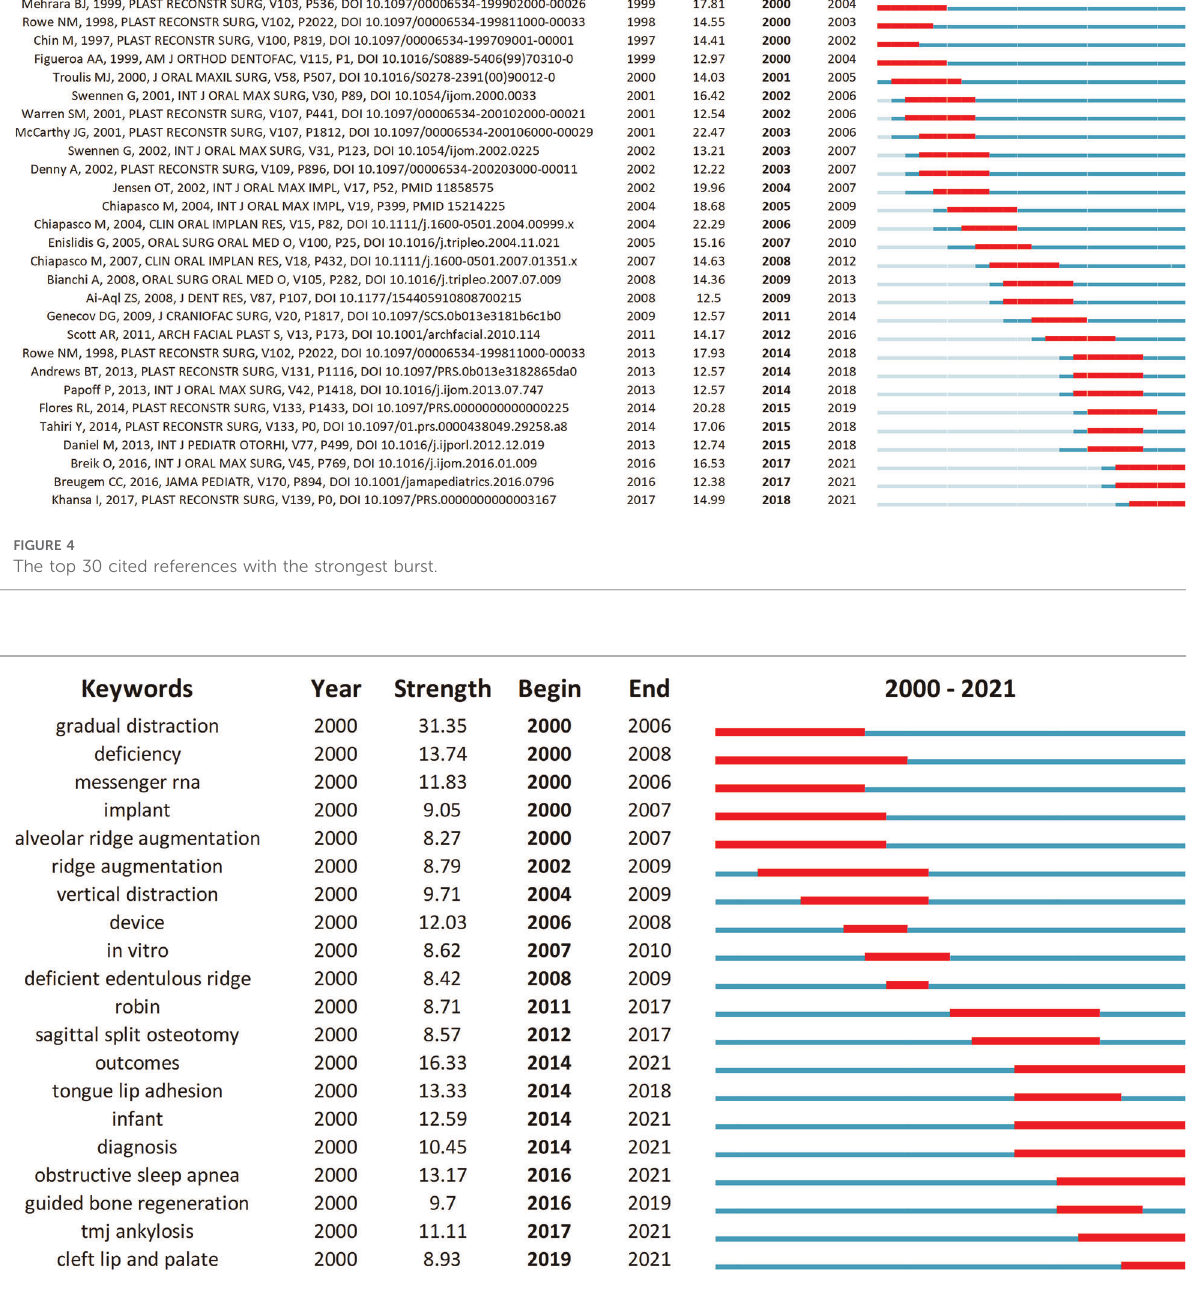
FIGURE 5 The top 20 keywords with the strongest